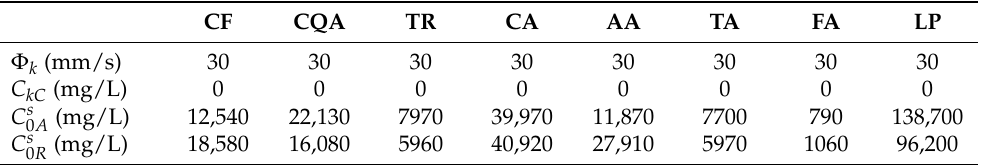
Table 7. Parameters in the initial and boundary conditions (5) and (6) of the chemical species. C s , C s are the initial concentrations for Arabica and Robusta, 0 R 0 A